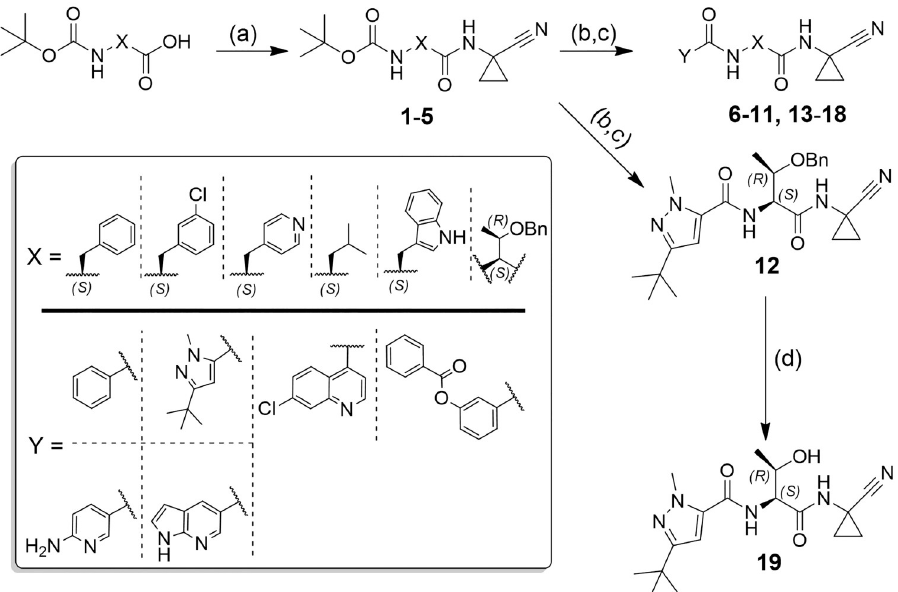
Fig 1. General synthesis of compounds 6–19. Reagents and conditions: a) HATU, DIPEA, 1-amino- 1-cyclopropanecarbonitrile, DMF, rt, 18 h; b) formic acid, rt, 18 h; c) HATU or TBTU, DIPEA, carboxylic acid, DMF, rt, 18 h; d) DDQ, CH 2 Cl 2 , rt, 3–5